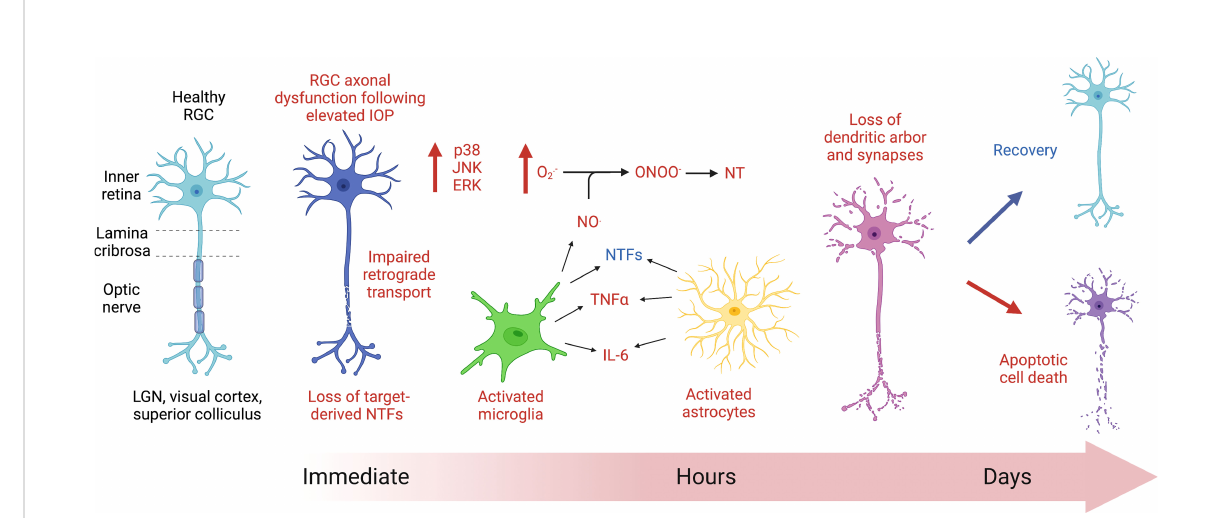
FIGURE 1 Cartoon diagram depicting the initial response of retinal ganglion cells (RGCs) to acute ocular hypertension. Axoplasmic stasis occurs immediately following RGC injury because of acute increases in intraocular pressure (IOP), affecting axonal transport. Within hours of injury, cell signaling changes occur, notably with the expression of mitogen activated protein kinases (MAPK, such as p38, JNK, and ERK). Glial cells, including microglia ( green ) and astrocytes ( yellow ), show evidence of increased reactivity within hours of the insult. Activated glial cells release nitric oxide (NO . ), which, when combined with superoxide (O : − 2 ), can produce the highly reactive intermediate compound, peroxynitrite (ONOO - ), which can then nitrate proteins on tyrosine residues (NT), interfering with protein function. There are noted morphological changes in RGC dendritic arborization within hours and throughout days following injury. Ultimately, the RGCs affected by increases in ocular hypertension will either recover or die via